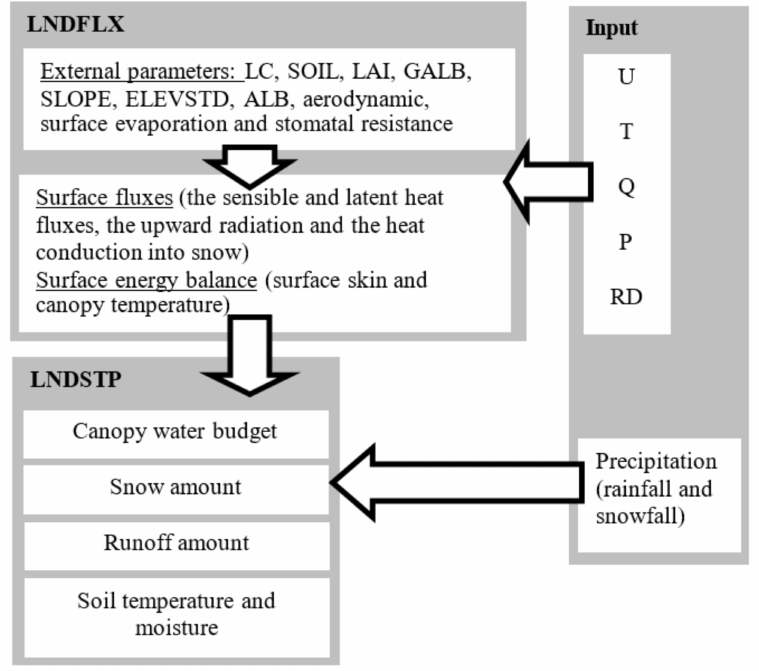
Figure 1. The structure and calculation flow in the Minimal Advance Treatments of Surface Interaction and Runo ff (MATSIRO) (reproduced from Takata et al., 2003). LC, land cover type; SOIL, soil type; LAI, leaf area index; GALB, ground albedo; SLOPE, surface mean slope; ELEVSTD, standard deviation of altitude in a grid cell; U, wind velocity; T, atmospheric temperature; Q, humidity; P, pressure; RD, downward